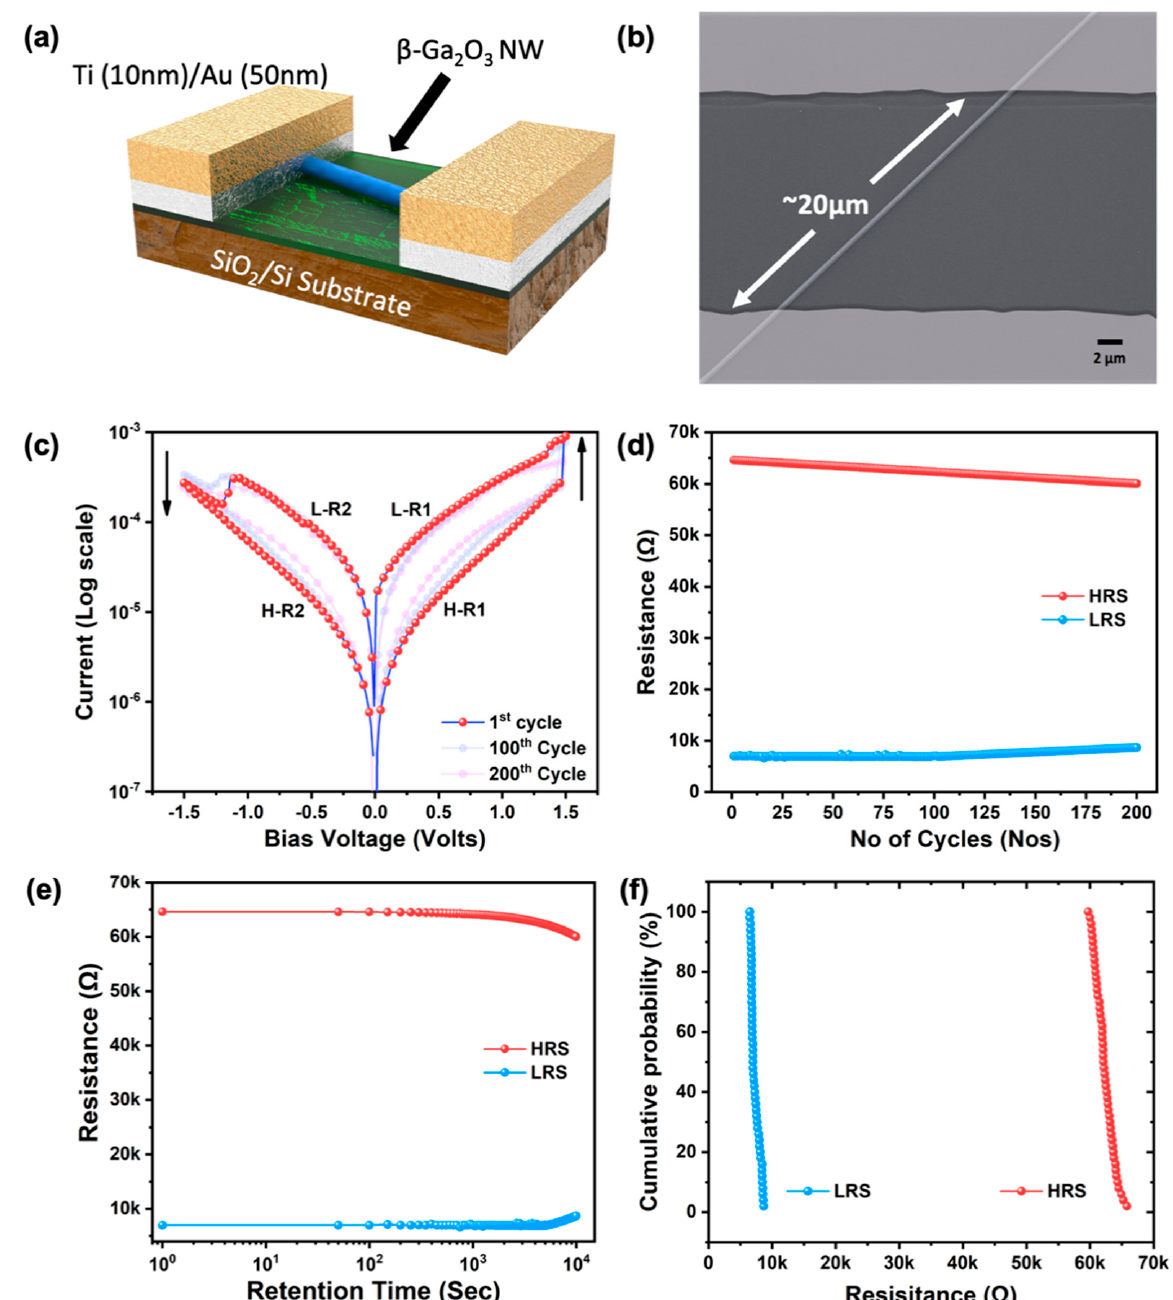
Figure 6. ( a ) Schematic diagram of the fabricated single β -Ga 2 O 3 nanowire ReRAM device, ( b ) SEM image of the fabricated single β -Ga 2 O 3 nanowire ReRAM device, ( c ) typical bipolar resistive switching curve of the single β -Ga 2 O 3 nanowire, ( d ) endurance cycle results, ( e ) retention time analysis results, and ( f ) cumulative probability analysis of the fabricated